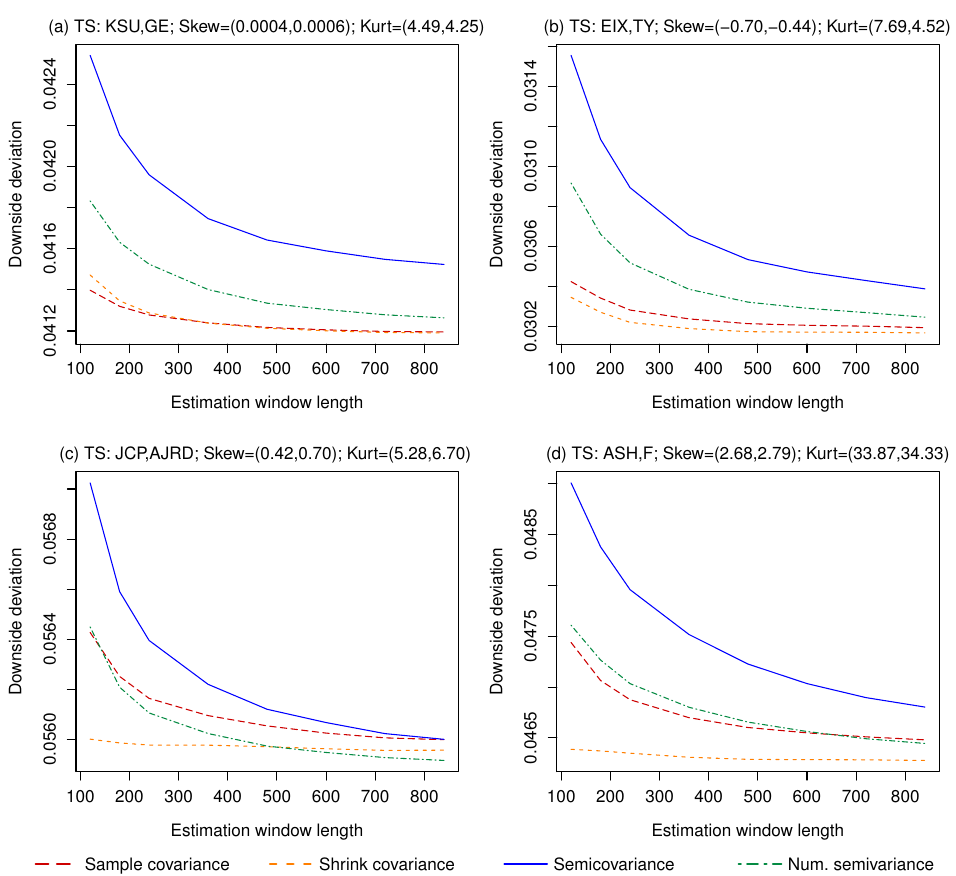
Figure 4. Downside deviation achieved by minimum variance/semivariance portfolios constructed with assets with different idiosyncratic skewness. ( a ) Virtually zero skew; ( b ) Negative skew; ( c ) Positive skew; ( d ) Very positive